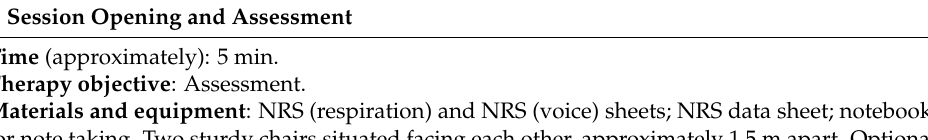
Table 1. Experimental music therapy treatment protocol to support bulbar and respiratory functions of persons with early- and mid-stage amyotrophic lateral